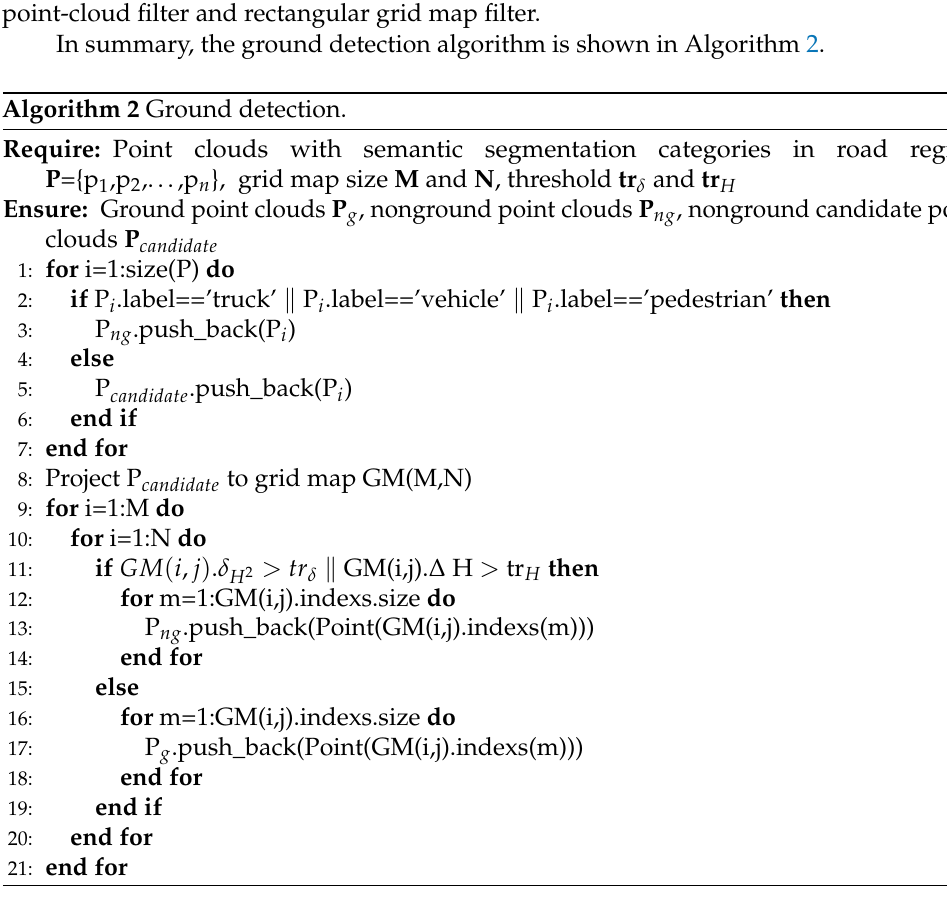
Algorithm 2 Ground